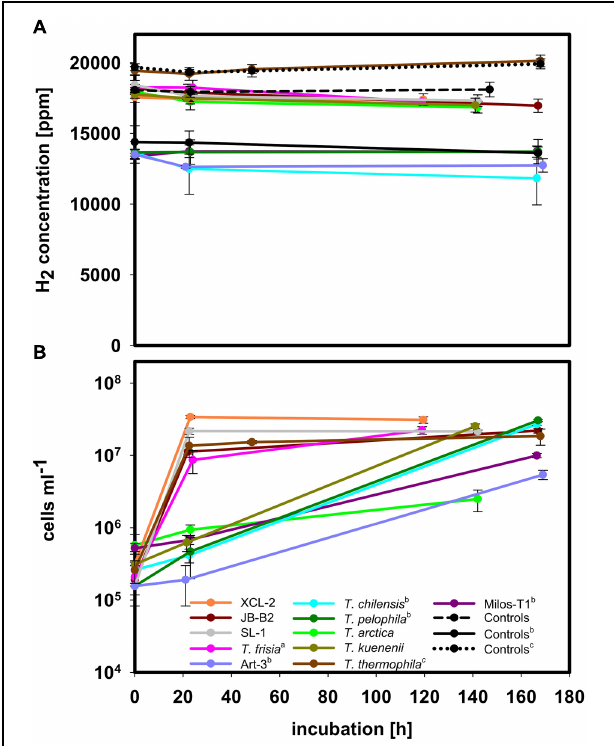
FIGURE 2 | H 2 consumption experiments with species not consuming hydrogen under incubation conditions. (A) H 2 concentration in the headspace during incubation. (B) Cell density during incubation of the respective species. All experiments were performed at 28 ◦ C except for T. arctica and T. thermophila, which were undertaken at 10 ◦ C and 37 ◦ C, respectively. Experiments were performed in MJ-T medium under an